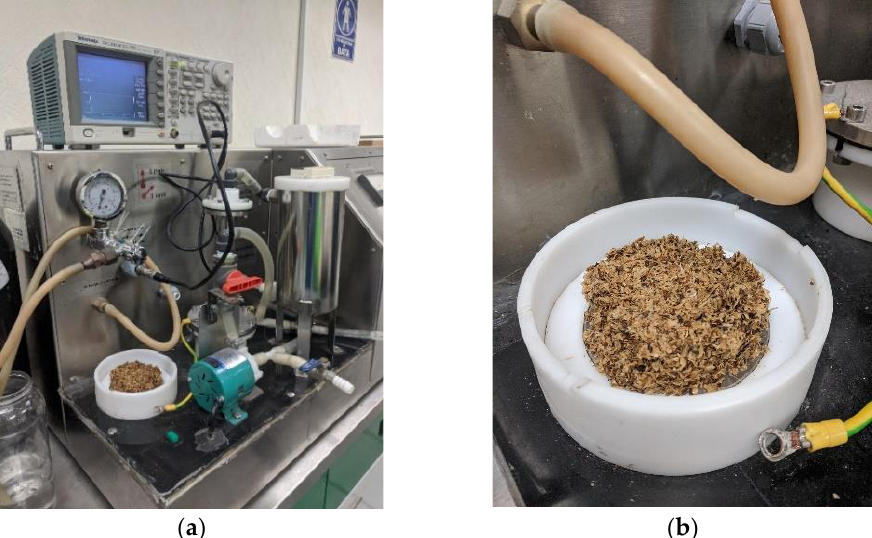
Figure 9. Pulsed-electric field (PEF) experimental setup. ( a ) PEF device layout, ( b ) treated coffee agrowaste on electrode detail. PEF: Pulsed Electric Field pretreatment.